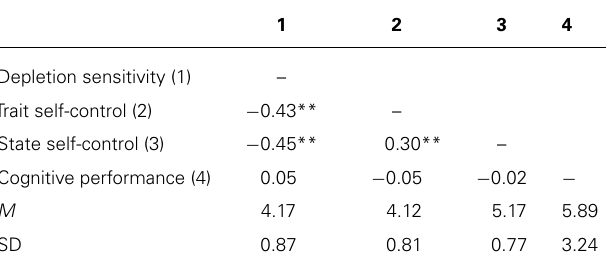
Table 4 | Means, SD and correlations Study